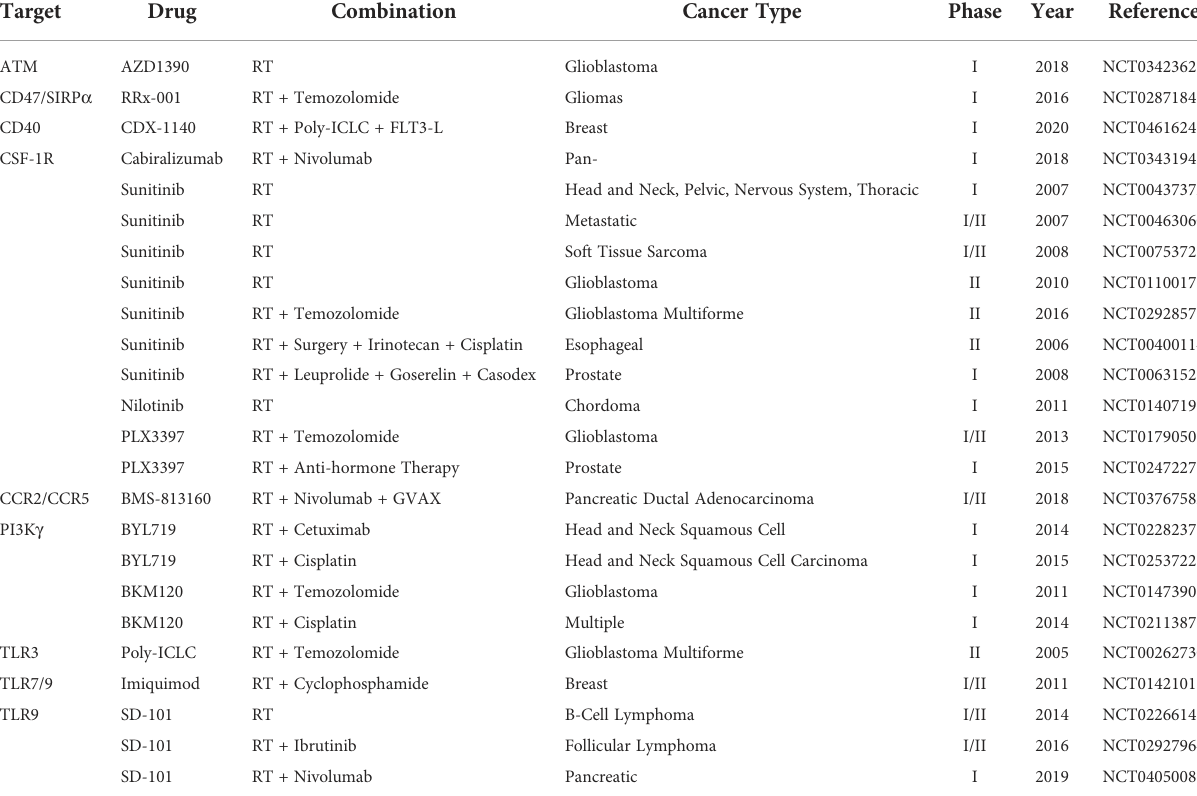
TABLE 1 Table summarizing latest clinical trials combining radiotherapy and approaches which may impact macrophage recruitment or